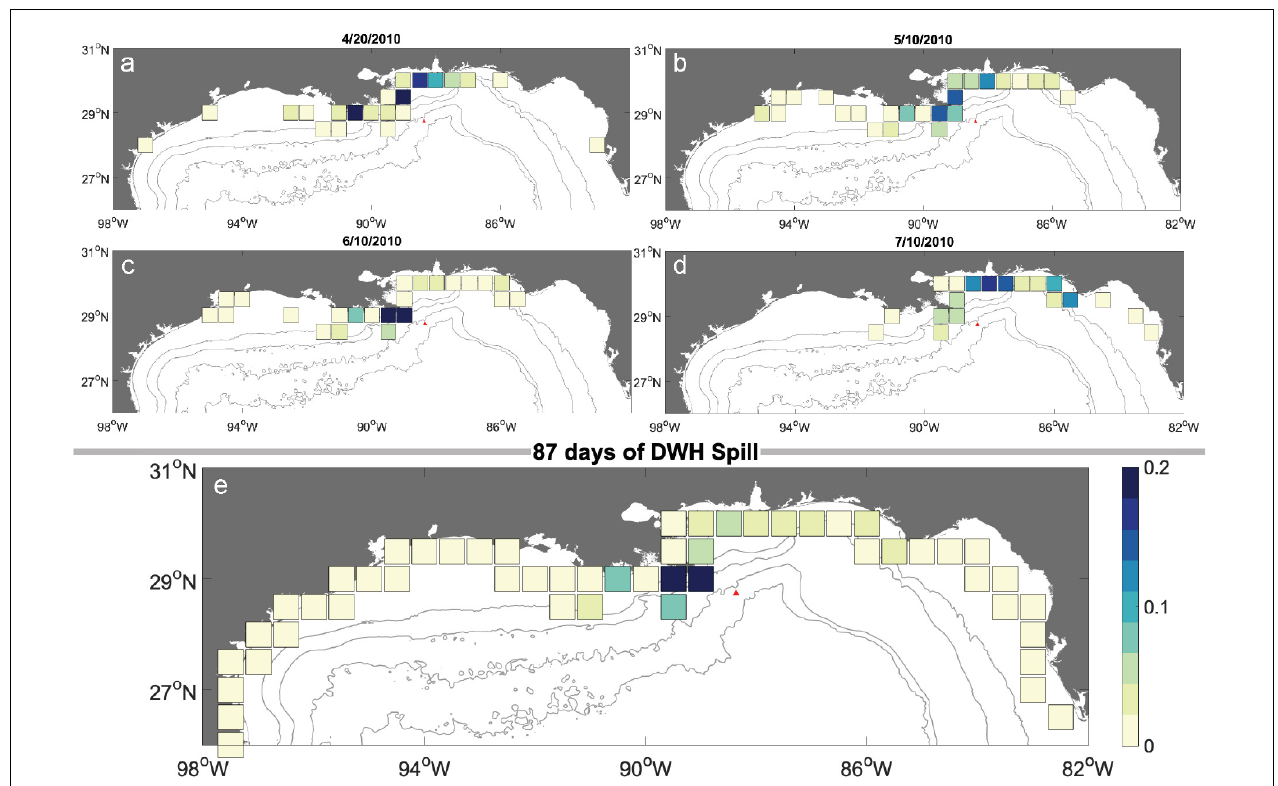
FIGURE 5 | Probability (PDFs) of sedimented photooxidized compounds from oil released on: (a) April 20th, 2010, (b) May 10th, 2010, (c) June 10th, 2010, (d) July 10th, 2010, and (e) during the 87 days of the DWH blowout, considering the high solar irradiance threshold scenario (i.e., photooxidation occurring when